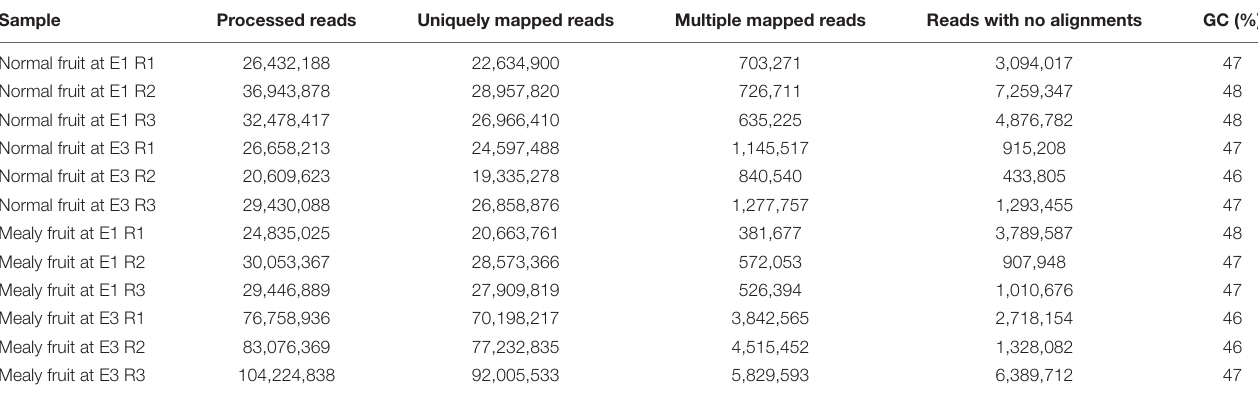
TABLE 4 | Parameters of Prunus persica transcriptome sequencing (RNA-Seq) and mapping of each sample and condition.